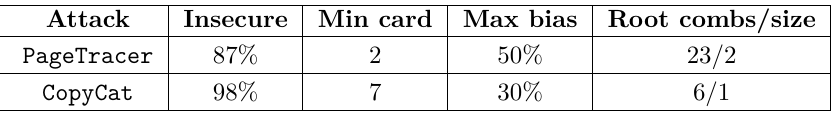
Table 2: libgcrypt combination